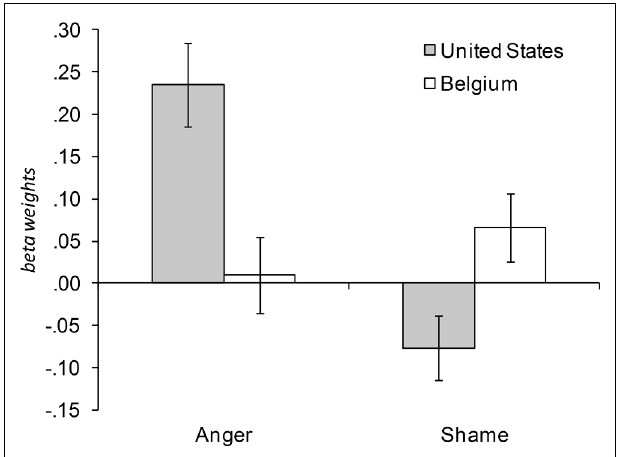
FIGURE 1 | Frequency of anger and shame situations as predicted by U.S. and Belgian students’ perception of the situations’ emotion-eliciting power . Beta weights of random slopes predicting situation frequency from the situation’s emotion-eliciting power (multi-level models with situations nested in participants). U.S. data from Boiger etal. (2013). Error bars show standard